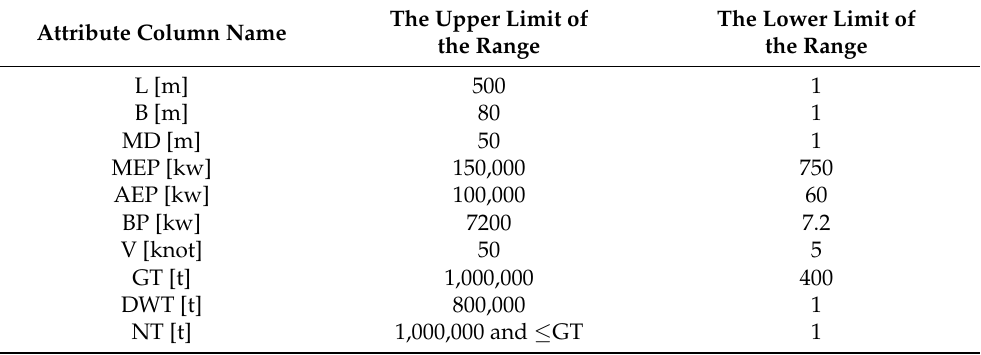
Table 1. The range of values for detecting outliers of the ship-related design parameters includes 10 design parameters, namely length (L), breadth (B), molded depth (MD), main engine power (MEP), auxiliary engine power (AEP), boiler power (BP), rated speed (V), gross tonnage (GT), deadweight tonnage (DWT), and net tonnage